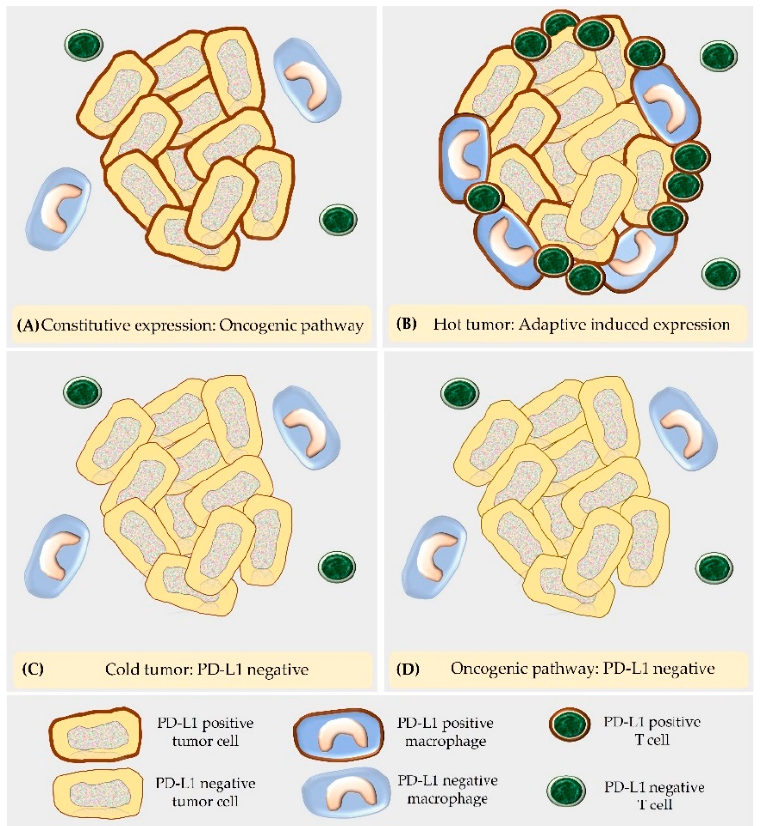
Figure 3. According to the underlying molecular mechanism, PD-L1 expression in tumor cells can be classified in four different categories, i.e., PD-L1-positive by the constitutive oncogenic pathway ( A ), PD-L1-positive by the adaptive induced PD-L1 expression in a “hot tumor” ( B ), PD-L1-negative in a “cold tumor” ( C ) and PD-L1-negative by the oncogenic pathway ( D ).